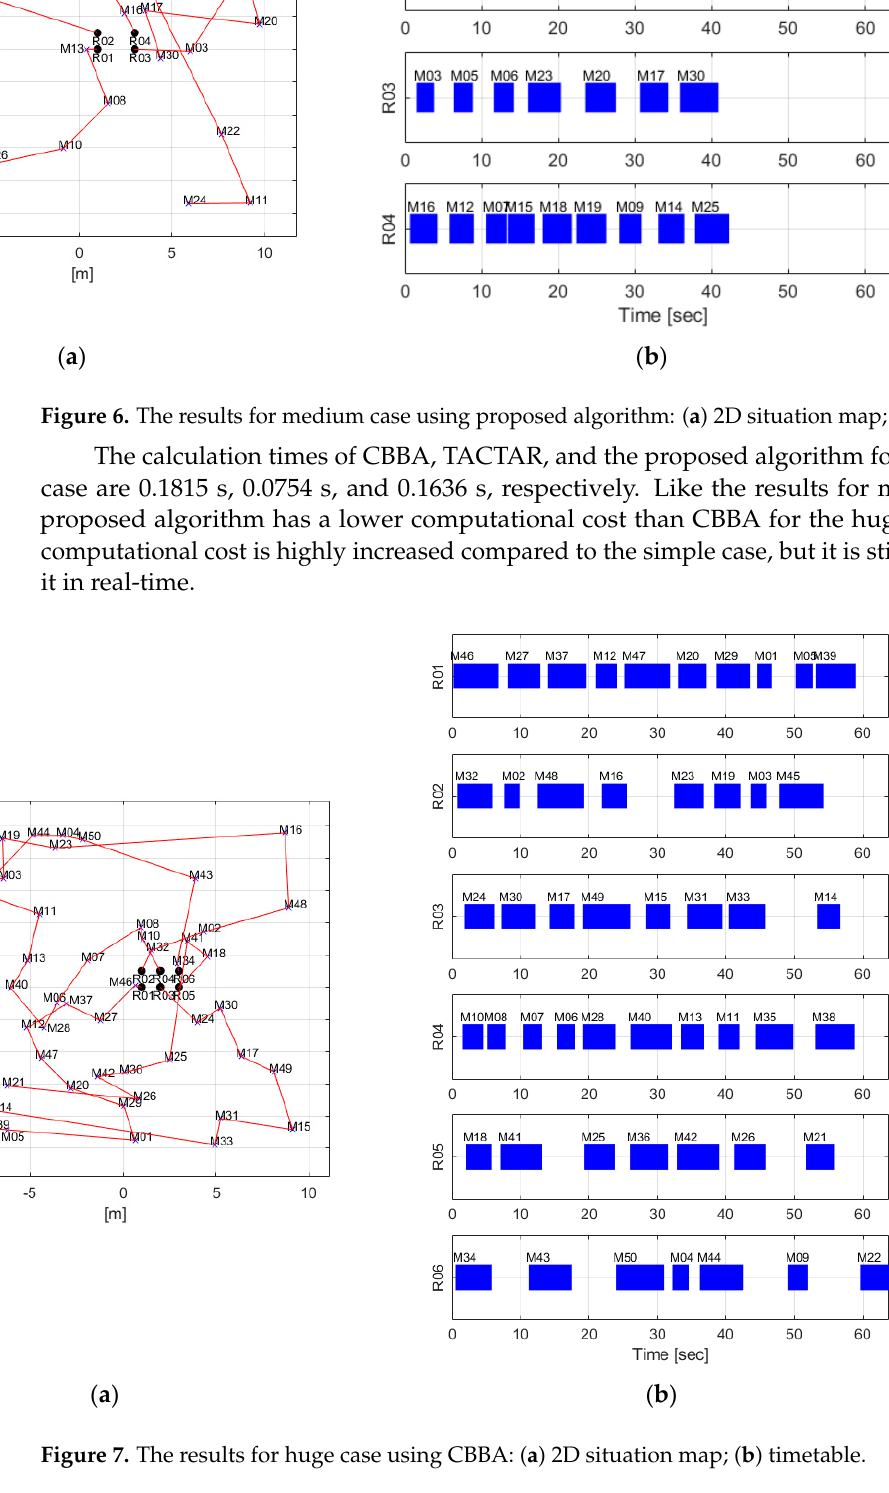
( b ) Figure 8. The results for huge case using TACTAR: ( a ) 2D situation map; ( b ) timetable.